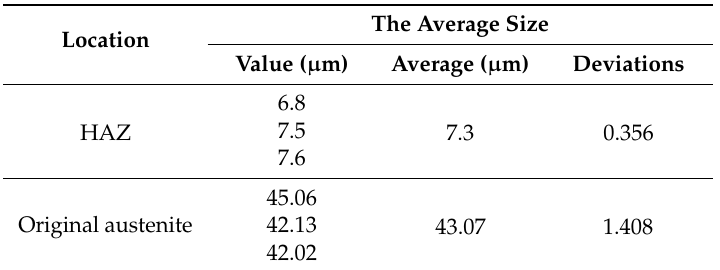
Figure 16. Austenite grains morphology at different holding times: ( a ) 300 s; ( b ) 600 s; and ( c ) 900 s.